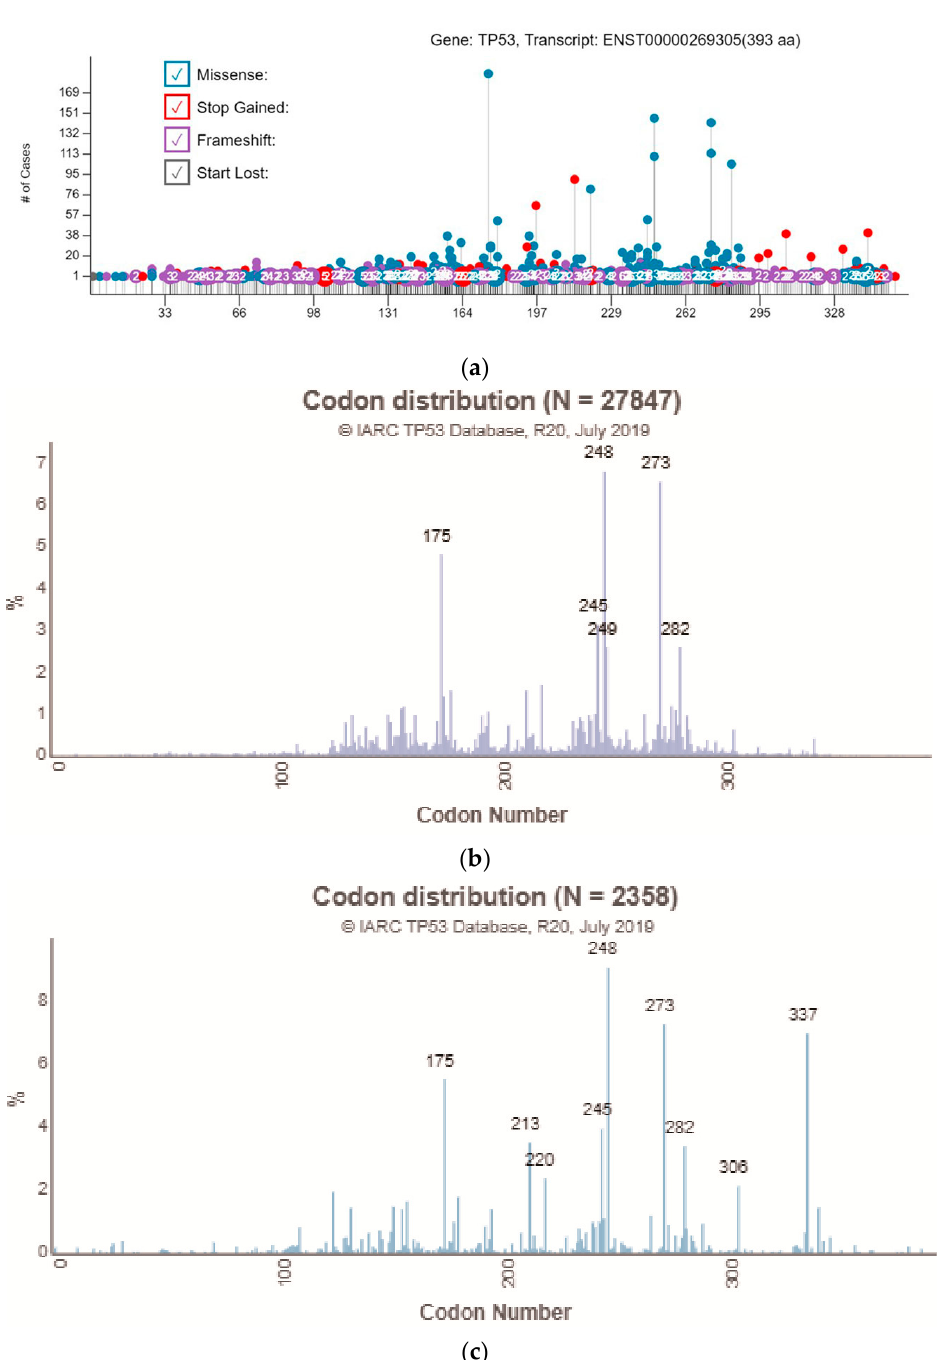
Figure 1. Distribution of TP53 mutations. ( a ) Distribution of TP53 mutations from the TCGA database. Picture obtained from National Cancer Institute GDC Data Portal; ( b ) Distribution of TP53 somatic mutations from the IARC TP53 database; ( c ) Distribution of TP53 germline mutations from the IARC TP53 database; and ( b , c ) Picture obtained from the IARC TP53 database website (https://p53.iarc.fr/ (accessed on 1 July 2021)).